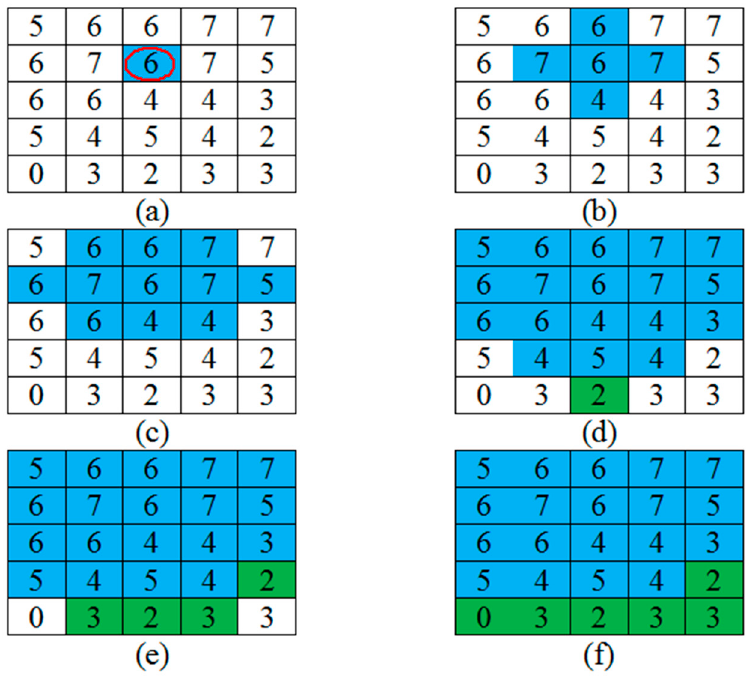
Figure 2. The region growing process using a 4-connected neighborhood. ( a ) The red circle indicates the initial pixel in the region of interest. ( b , c ) The blue color represents the pixels that are considered to belong in the same region as the initial pixel. ( d – f ) The green color indicates pixels that are excluded from the region because the difference is larger than the threshold value.